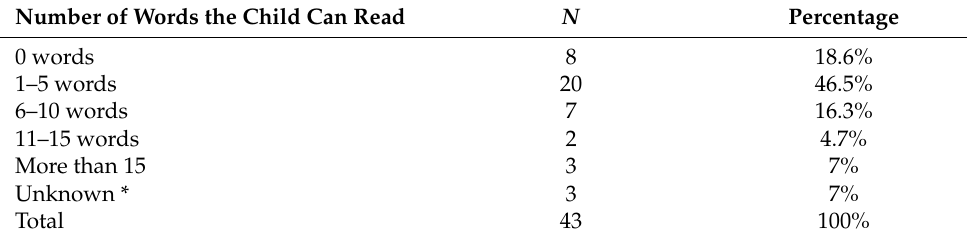
Table 1. Overview of the number of words recognized by the children at T1 based on parental reports. Number of Words the Child Can Read